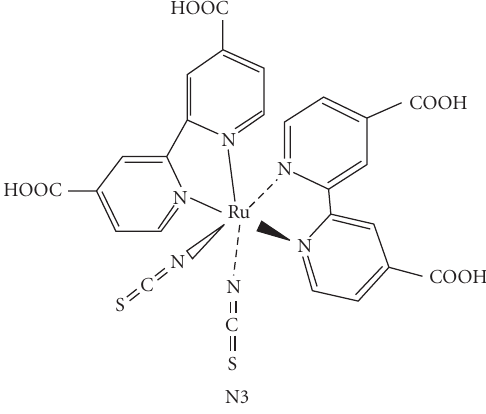
Figure 3: Chemical structure of a typical sensitizing dye N3 used for dye-sensitized solar cells.